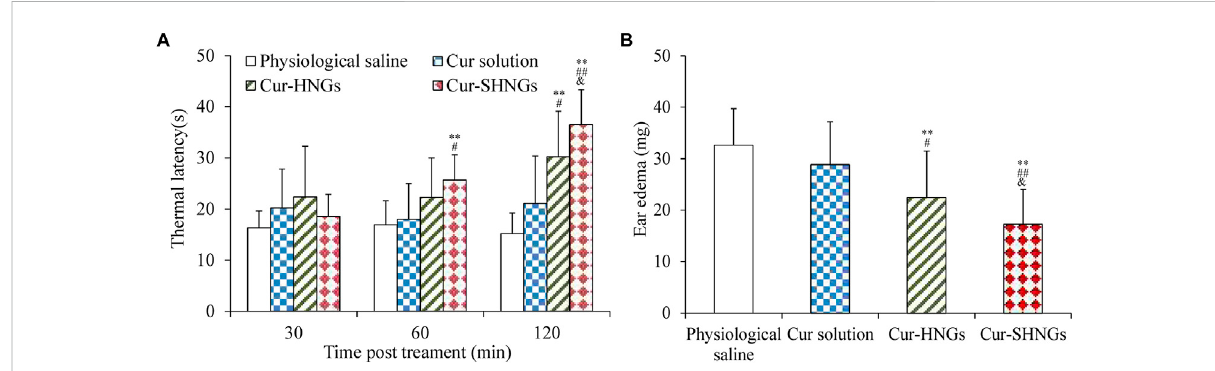
FIGURE 8 (A) Thermal latency of physiological saline,Cursolution, Cur-HNGs, andCur-SHNGsinmice atvarious time intervals on thehot plate; (B) Effect of physiological saline, Cur solution, Cur-HNGs, and Cur-SHNGs on the weight of dimethyl benzene induced mice ear edema. (** p < 0.01 as compared to physiological saline group, # p < 0.05 and ## p < 0.01 as compared to Cur solution group, & p < 0.05 as compared to Cur-HNGs